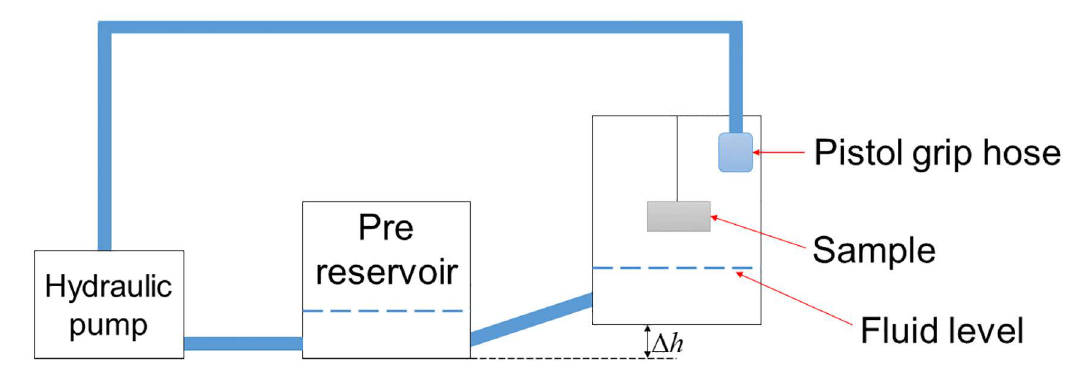
Figure 3. Schematic drawing of the device developed to simulate machining process